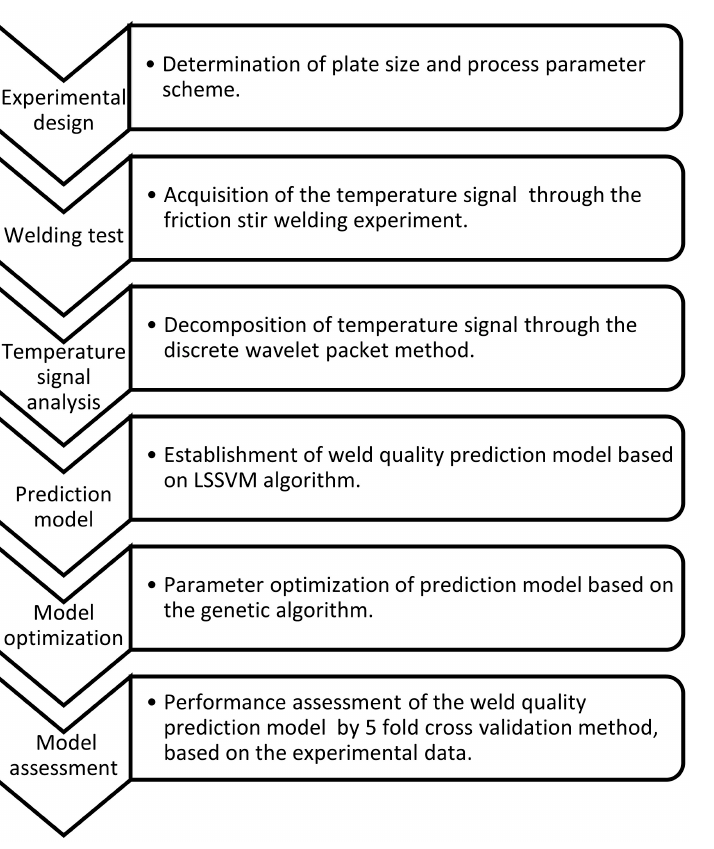
Figure 11. Process and approaches of constructing FSW quality prediction model.